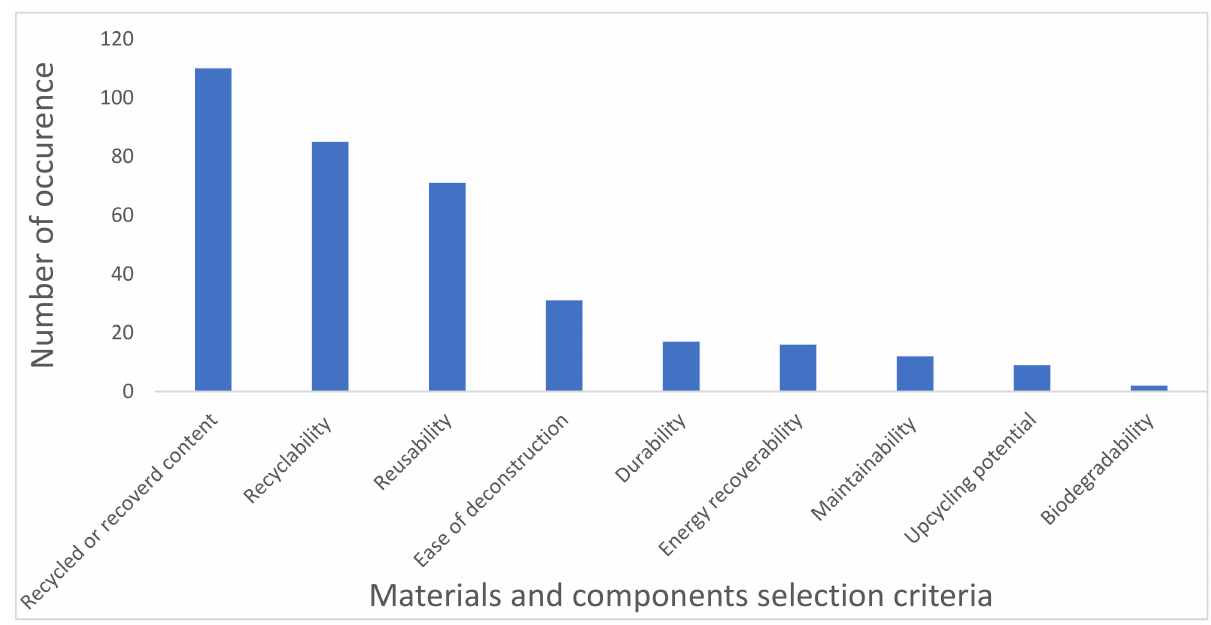
Figure 5. Materials and components selection criteria according to selected